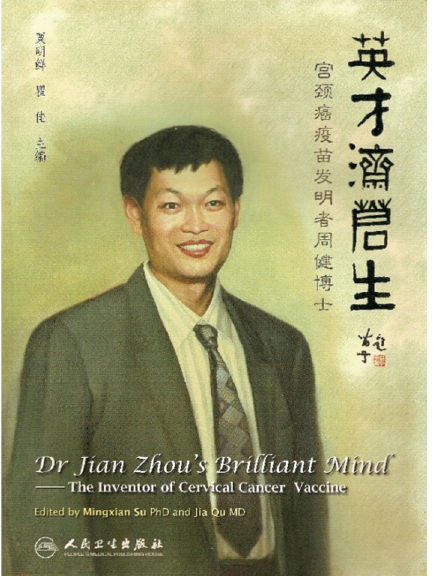
Figure 6. Cover photo of Dr. Jian Zhou memorial